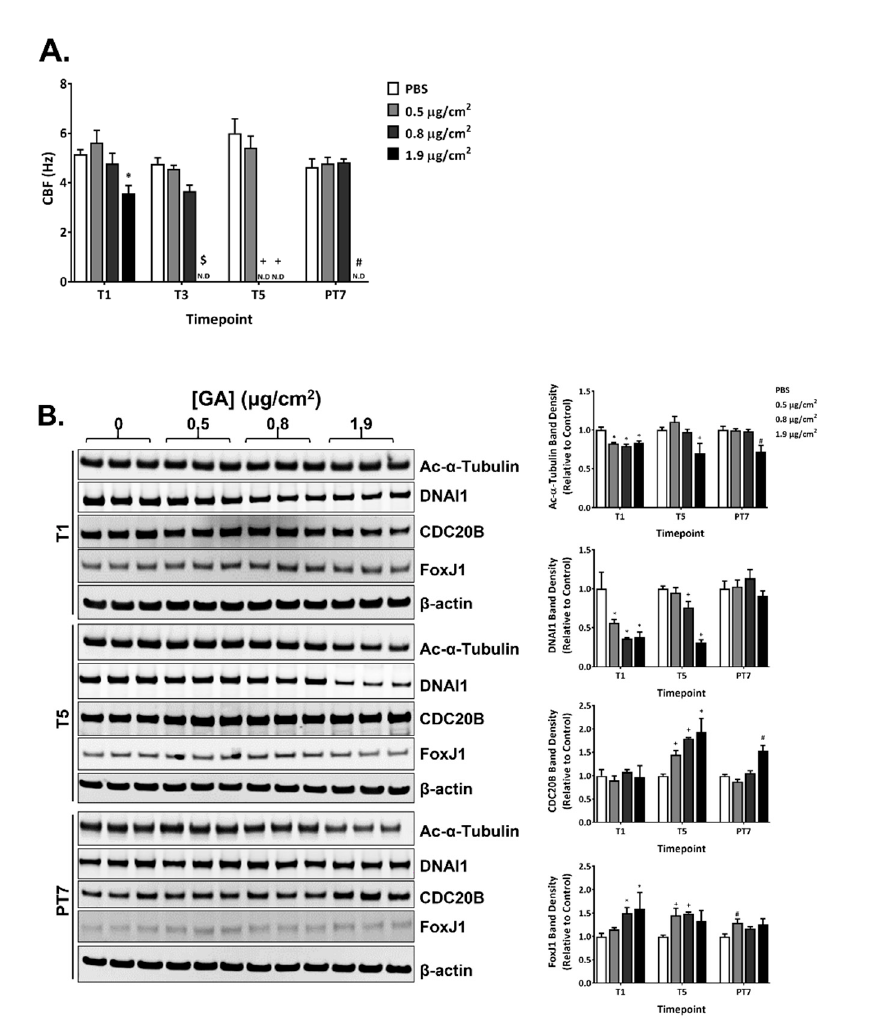
Figure 5. Inhibitory effects of GA aerosols on ciliary cells in the ALI cultures. CBF ( A ) was measured at T1, T3, T5, and PT7. ( B ) Expression of a panel of ciliary proteins was evaluated at T1, T5, and PT7 by immunoblotting. Representative images are shown in the left panel. The relative expression of these proteins is presented in the right panel. N.D: not detected. Data ( n = 3) are expressed as means ± SEM. * ,+,$,# p < 0.05 was considered statistically significant compared to the respective vehicle controls.